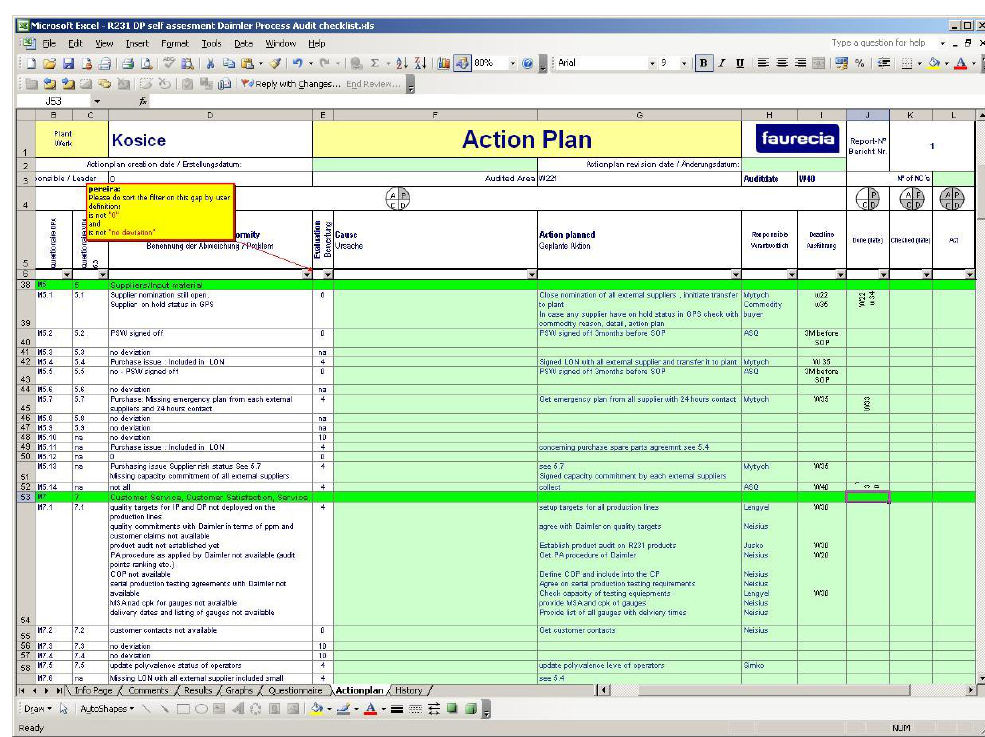
Figure 2 - Action plan from